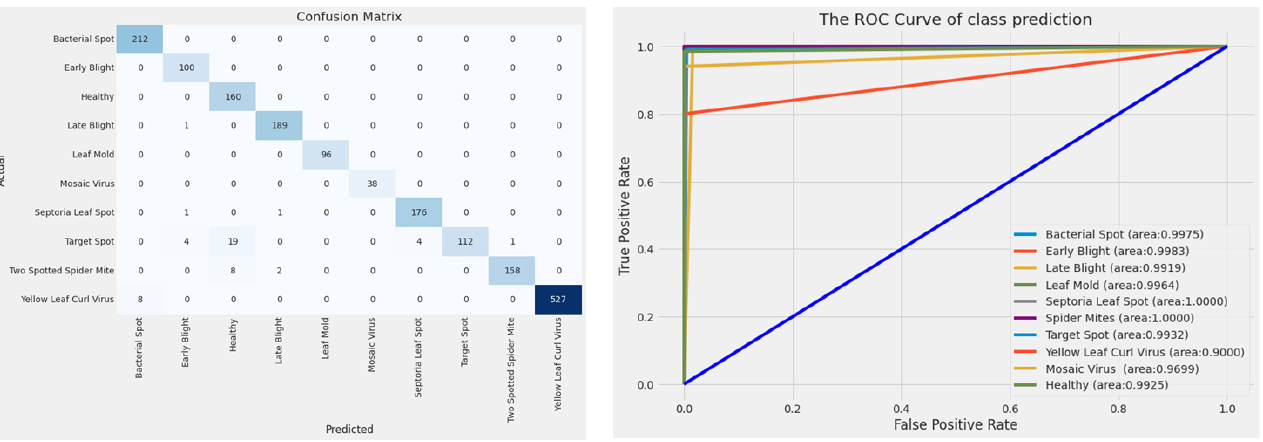
Figure 8. Confusion matrix and ROC curve of ResNet152 model on the tomato test data.